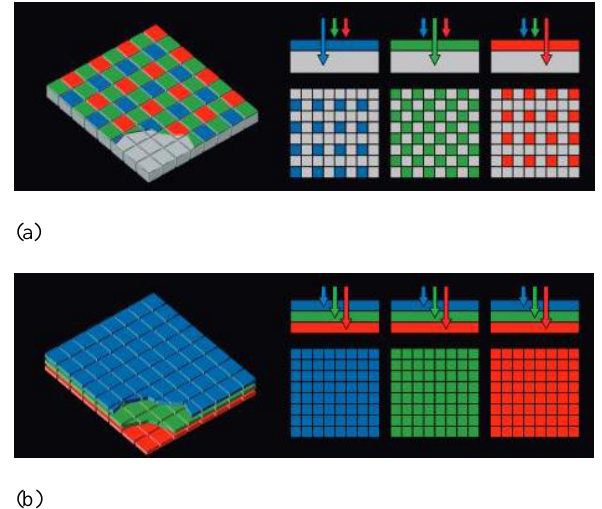
Figure 1. Incoming radiation and filters used on an image sensor: a) Bayer CFA; b) Foveon X3® ( Sigma Corporation, 2010 ) All rock art images were taken including a color chart within the scene. The X-rite ColorChecker SG Digital Color Chart was